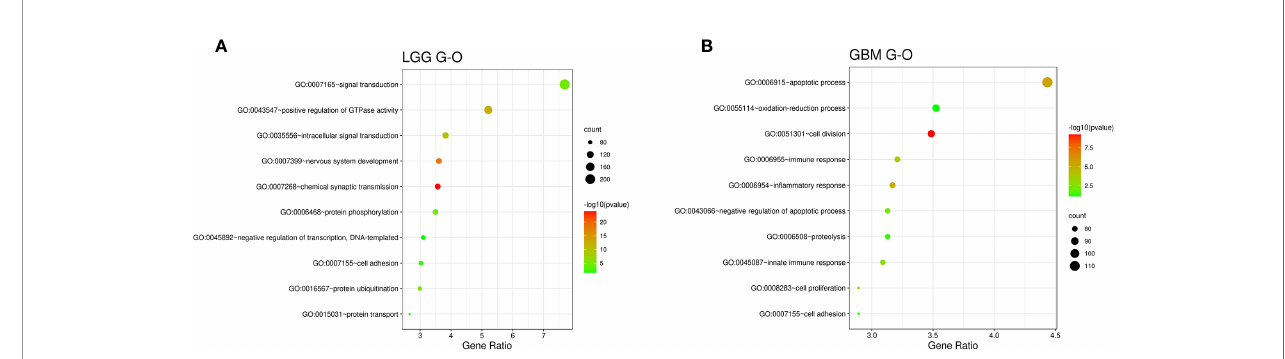
FIGURE 3 | Functional enrichment analysis of associated genes for LGG (A) and GBM (B) , indicating the functional roles of the gene sets in the different subgroups. Enrichment results for biological processes were obtained from the GO database. The orders of the biological processes listed in the bubble chart are based on the number of targets annotated in biological process (BP).